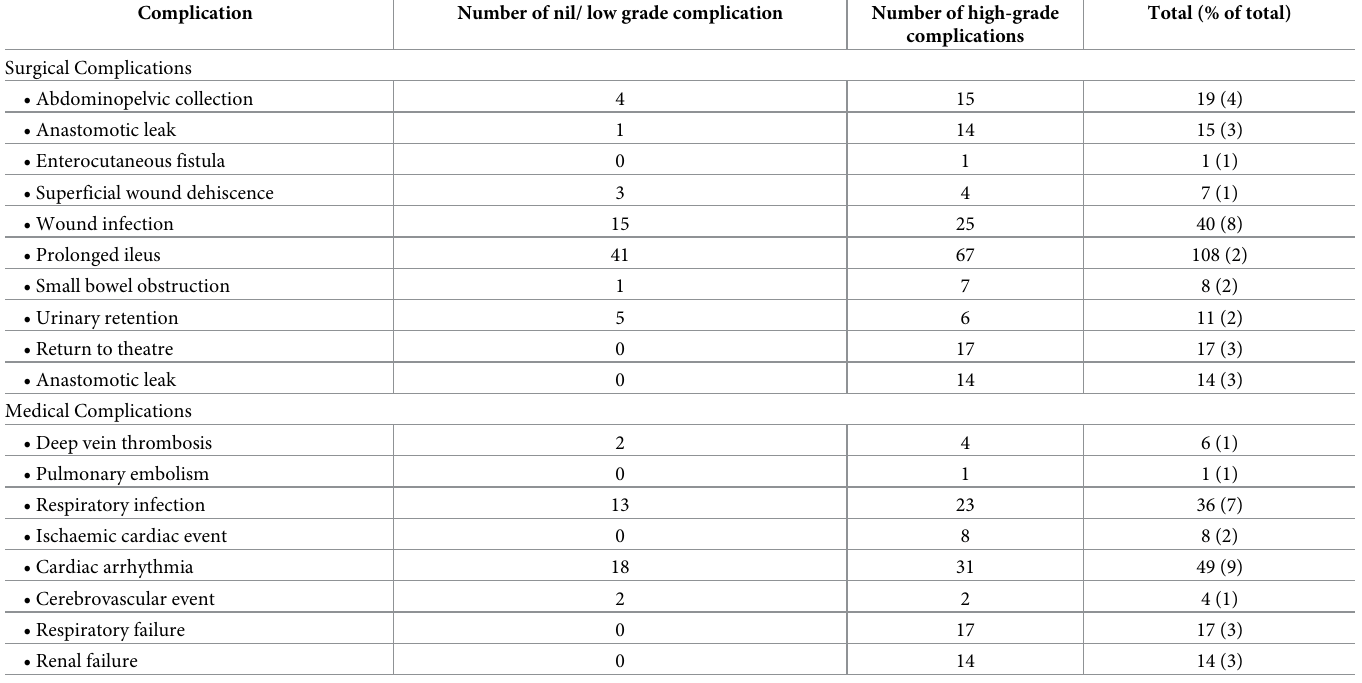
Table 3. Surgical and pathological features of patients who underwent colorectal cancer resections at The Prince Charles Hospital between 2010–2018.